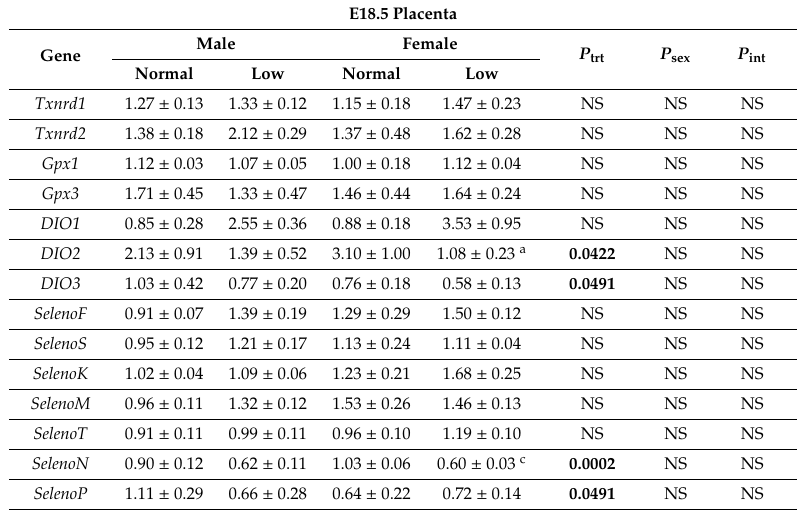
Table 4. E ff ects of selenium deficiency on selenoprotein expression in the placenta at E18.5. E18.5 Placenta Male Female P Gene trt P sex P int Normal Low